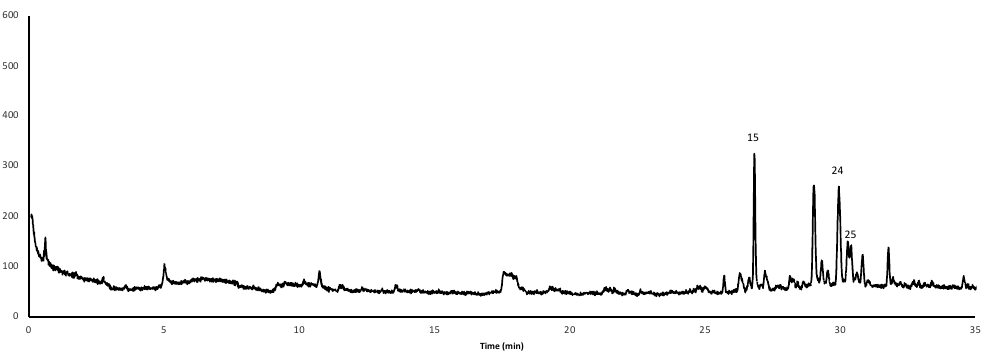
Figure 4. GC/MS chromatogram of VOC s emitted by sepals of P. ‘Endsleigh’ flowers at full bloom. The peak numbers correspond to the compounds listed in Table 5.